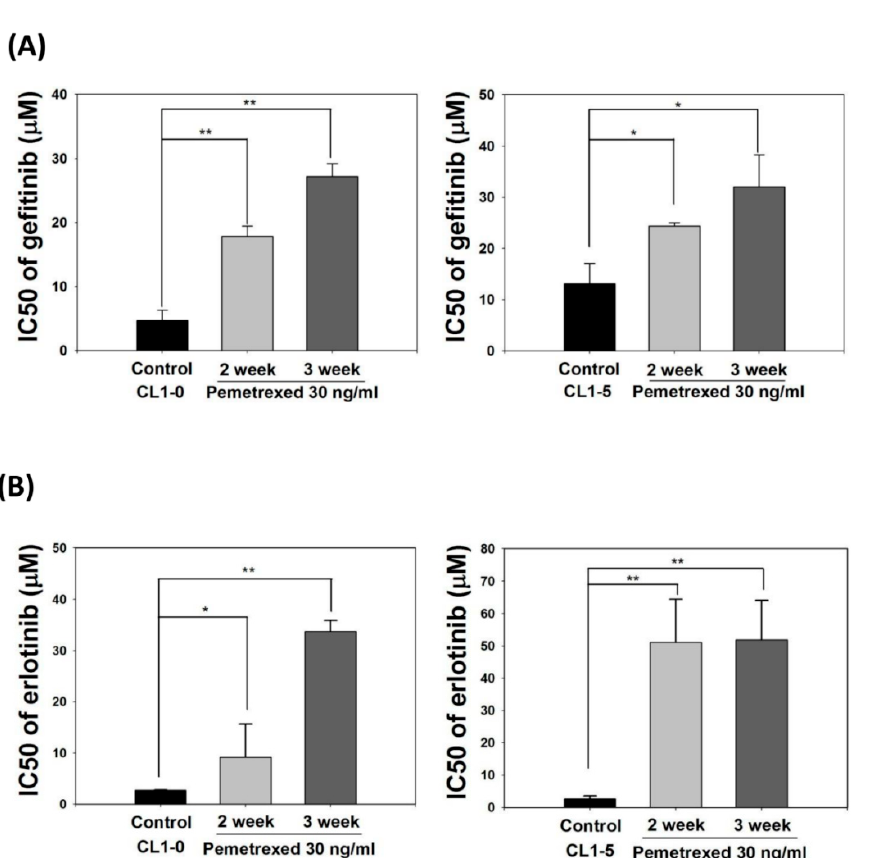
Figure 3. Pemetrexed aggravates EGFR-TKI resistance acquisition in NSCLC cells. NSCLC cells (CL1-0 and CL1-5) were cultured in pemetrexed-free or pemetrexed-containing (30 ng/mL) mediums for 2–3 weeks, followed by treatment with various concentrations of ( A ) gefitinib or ( B ) erlotinib (0.1–100 μ M) for an additional 3 days in 96-well plates. IC 50 values of gefitinib or erlotinib for these NSCLC cells demonstrated that pemetrexed unilaterally promoted EGFR-TKI resistance acquisition in the NSCLC cells. * p < 0.05; ** p < 0.01.